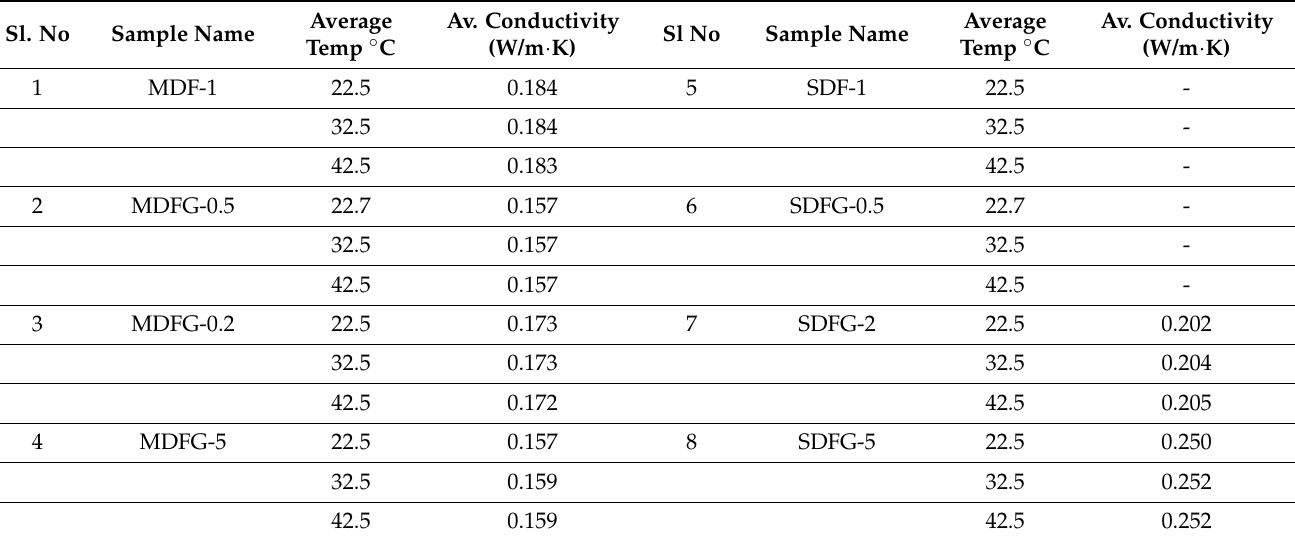
Table 4. Thermal Conductivity of the Prepared